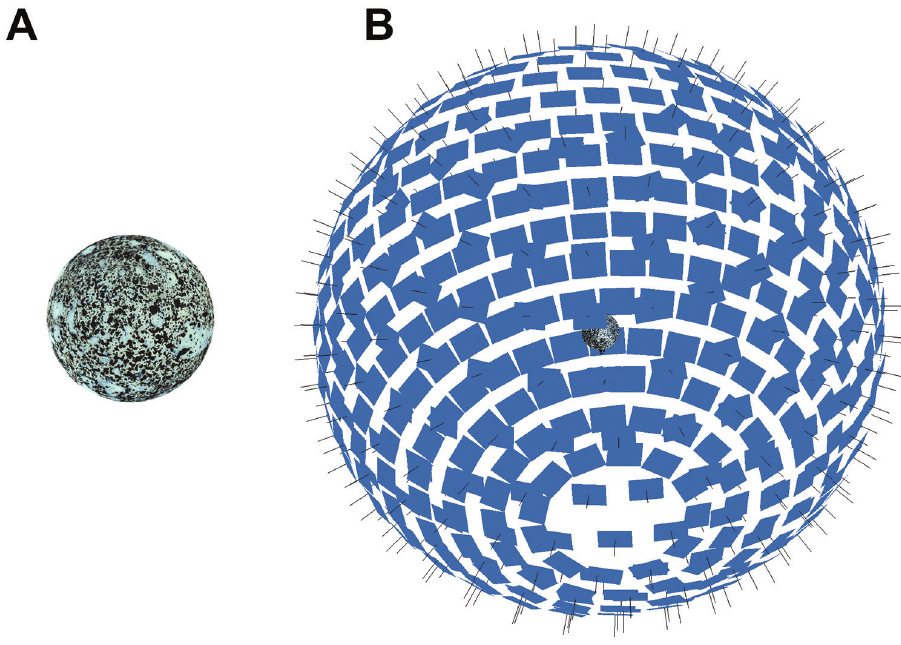
Figure 6. Calibration sphere ( A ) and camera positions estimated in PhotoScan Pro ( B